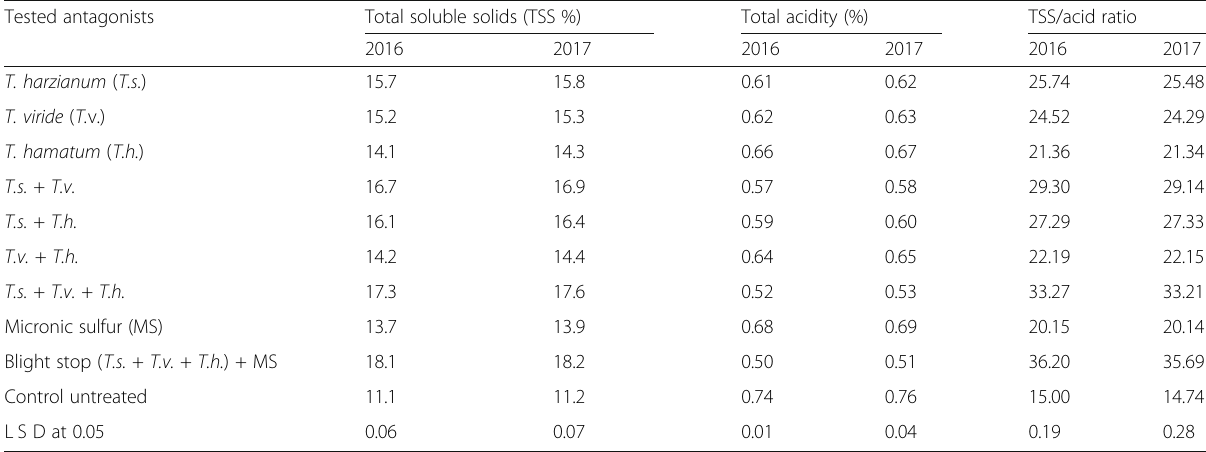
Table 3 Effect of different antagonists and micronic sulfur on total soluble solids (TSS), total acidity, and TSS/acid ratio of Thompson grapevine under Egyptian field conditions during 2016 and 2017 seasons Tested antagonists